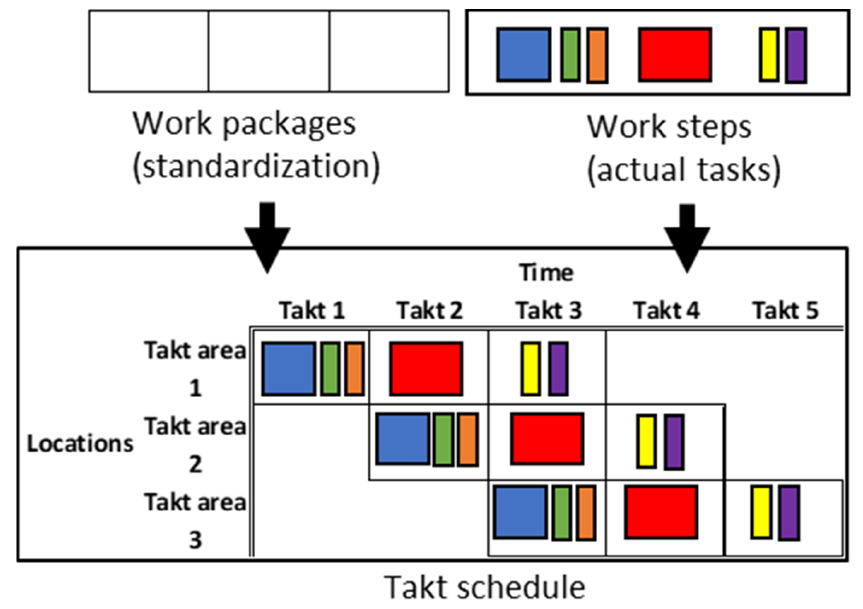
Figure 2. A takt schedule consists of takt areas, work packages and work steps included in the work packages (adapted from